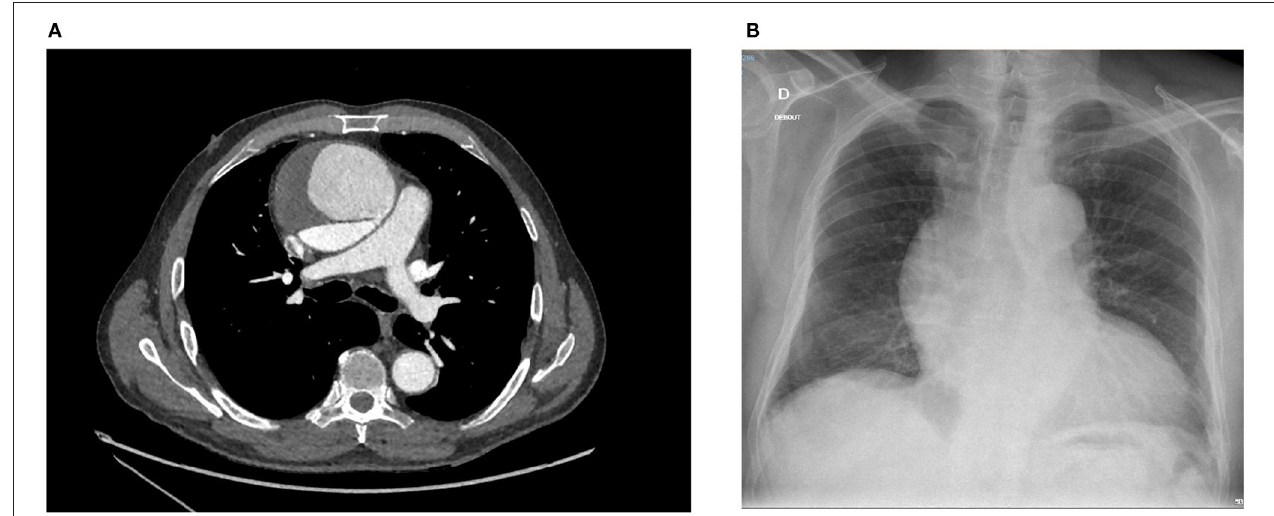
FIGURE 1 | (A) Contrast medium thoracic CT scan showing a CTAAD with a thick intimal tear (7mm) and an enlarged ascending aorta (82 × 87mm). The false lumen is partially thrombosed. (B) Chest X-ray showing an aortic aneurysm with a widening of the mediastinal silhouette, an enlargement of the aortic knob, and a displacement of the trachea from the midline. CT, computed tomography; CTAAD, chronic type A aortic